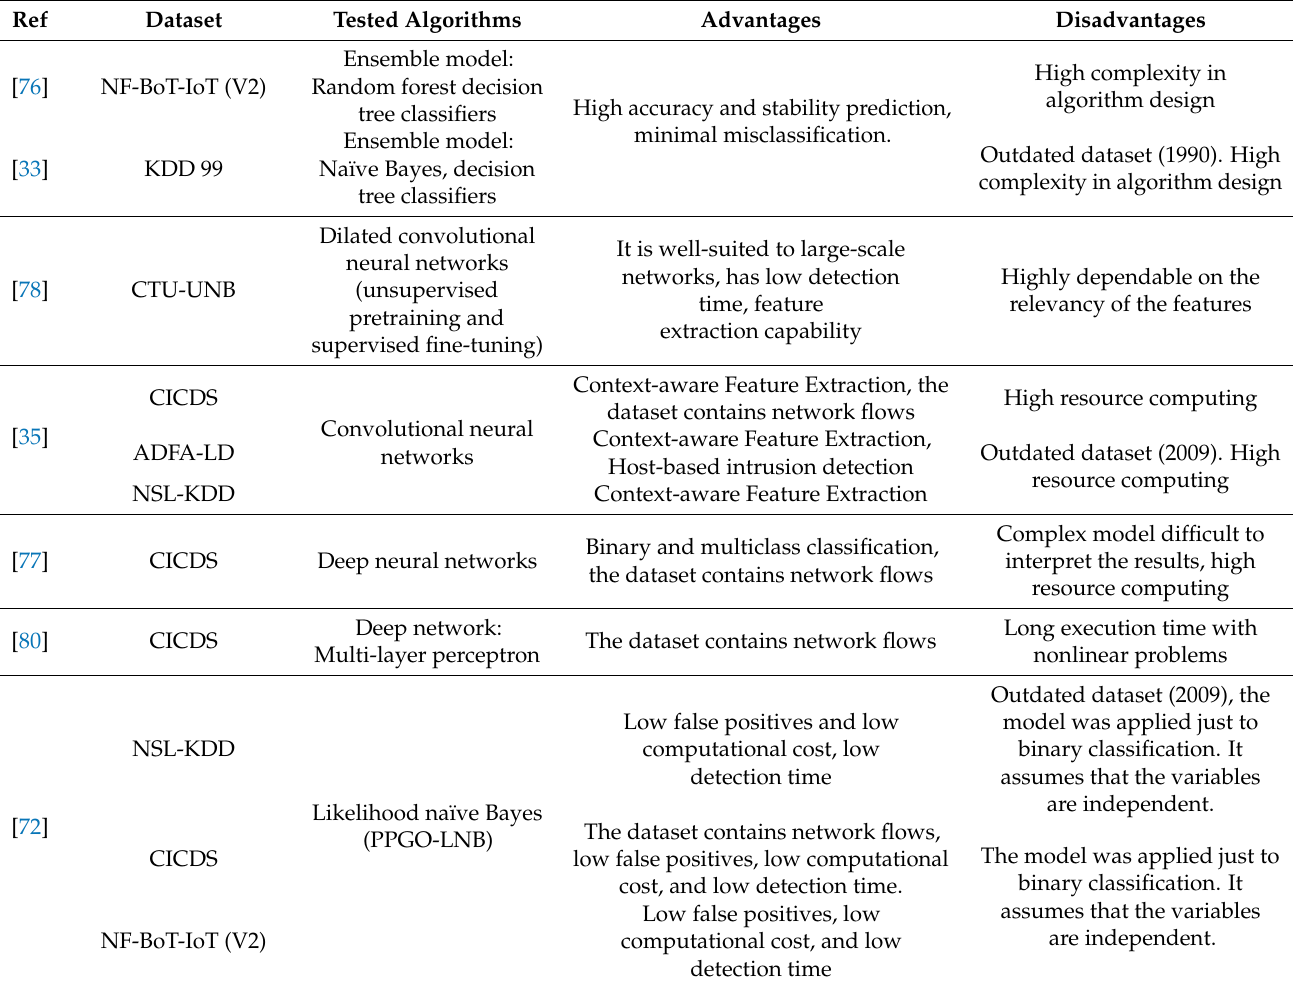
Table 6. Advantages and disadvantages of previous works that use ML to detect cyber-attacks.